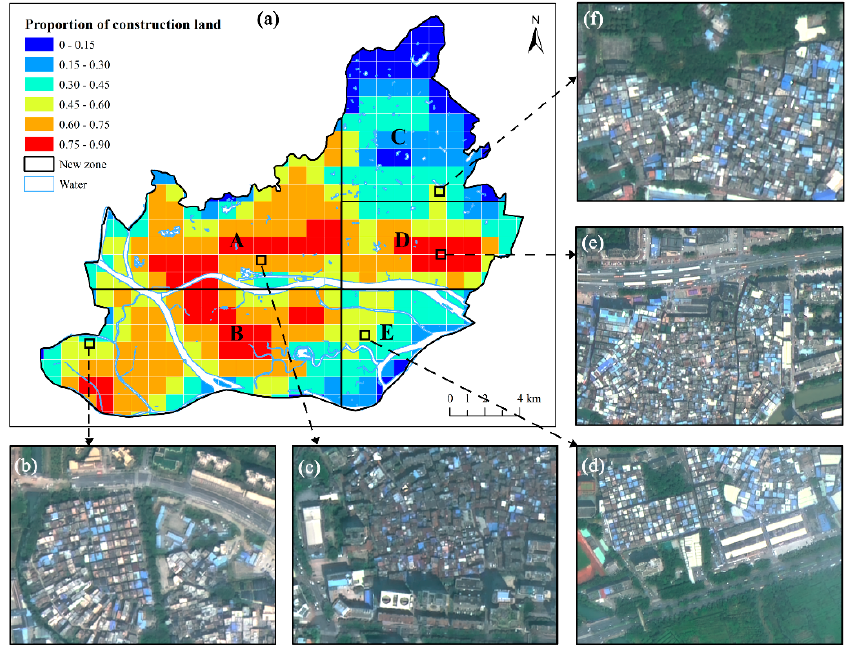
Figure 4. Partition strategy in study area. ( a ) Partition based on proportion of construction land; ( b – f ) UVs in five zones.